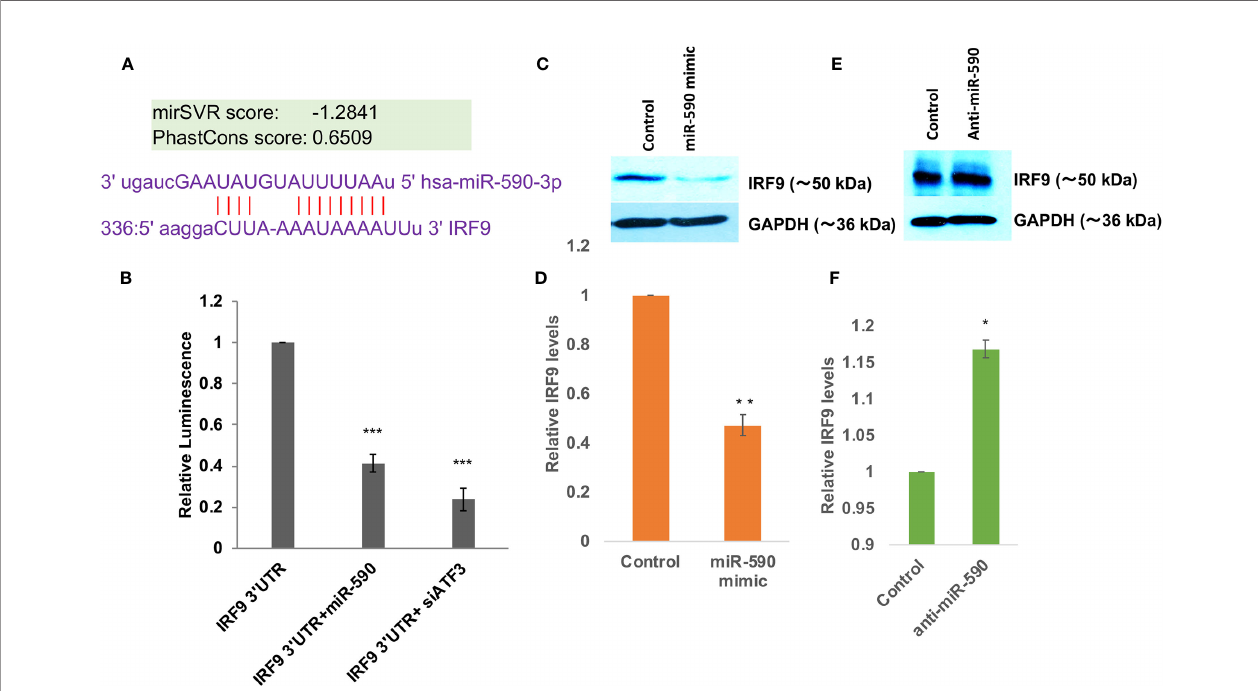
FIGURE 3 | miR-590 directly targets IRF9 expression levels (A) Image showing complementary binding between 3 ’ UTR of IRF9 and seed sequences of miR-590. (B) Graph bars showing results of dual luciferase assay for establishing direct binding and targeting of 3 ’ UTR of IRF9 gene by miR-590. Dual luciferase assay were performed by co-transfection methods in HEK-293T cells in 6 well plate format, lysed and measured with Promega luciferase assay kit. Renilla luciferase plasmids have been co-transfected for normalization and getting true changes in luciferase values. (C) Immunoblot image showing decrease in IRF9 expression levels after miR-590 mimic transfection in CHME3 cells. Lipofectamine RNAiMax have been used for miR-590 mimic transfection in 6 well plate format with 1x10 5 cells at the time of transfection. (D) Graph bars displaying densitometry analysis for average IRF9 level change after miR-590 overexpression. (E) Immunoblot image showing rescued expression levels of IRF9 upon anti-miR-590 transfection in human microglial cell line CHME3. 100 picomoles anti-miR-590 were transfected with Lipofectamine RNAiMax reagent in 6 well plate format with 1x10 5 cell. (F) Graph bars showing average change in IRF9 levels after anti-miR-590 transfections. All the experiments have been independently repeated three times to get the average changes in expression levels. Graph bars are displaying mean and mean ± S.E.M. student ’ s t-test have been performed to obtain the statistical signi fi cance indicated as single * for p values <0.05, ** for p values <0.005 and *** for p values